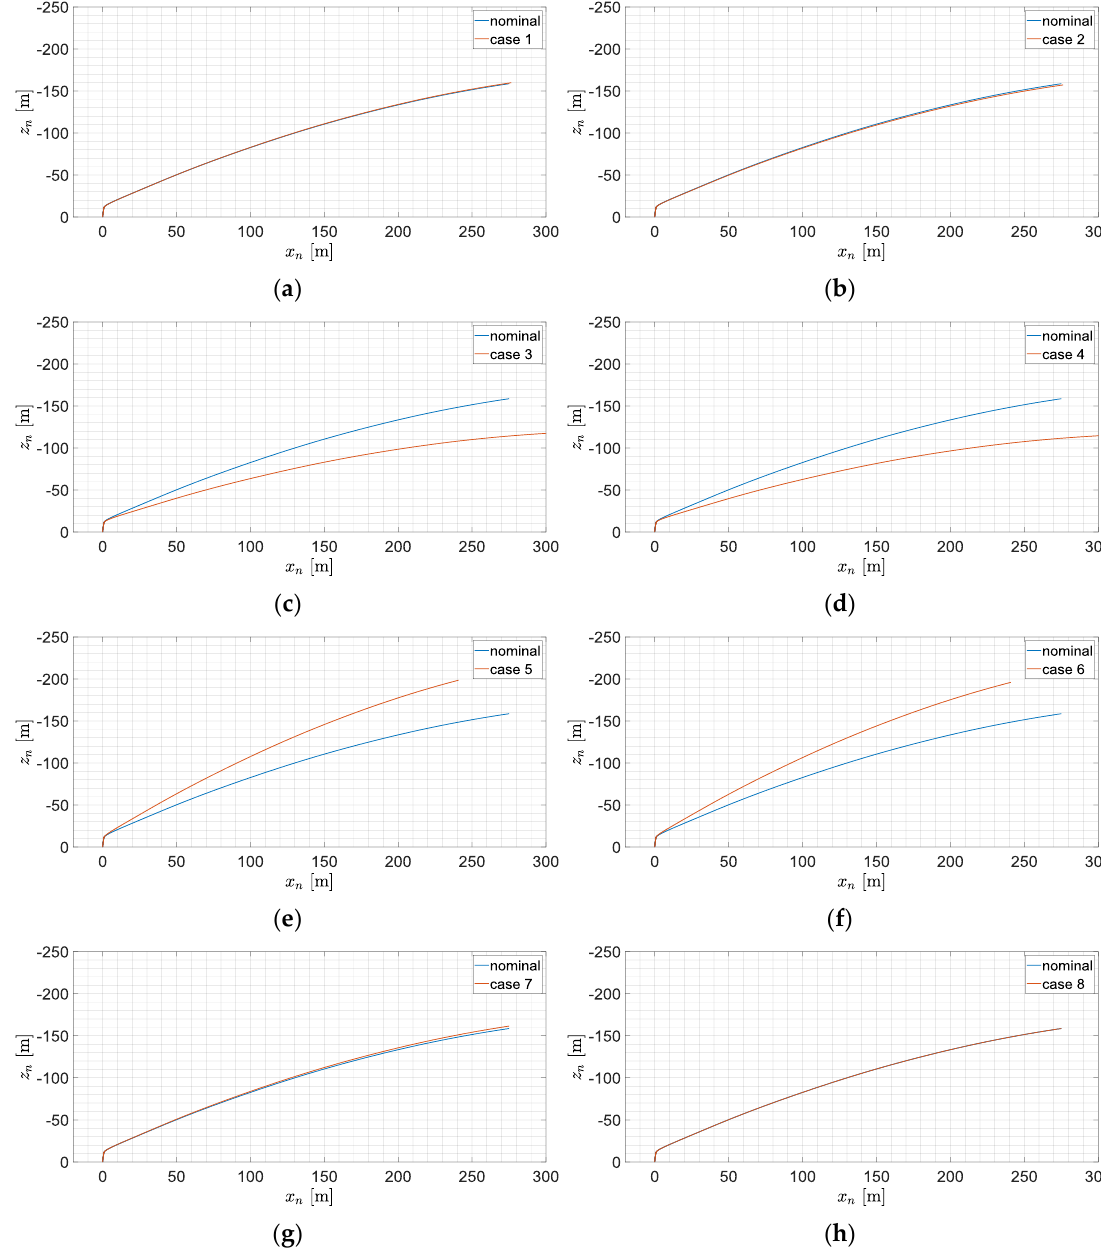
Figure 14. Projectile trajectories’ projections on 𝑂 𝑛 𝑥 𝑛 𝑧 𝑛 for various 𝜏 1 , 𝜏 2 , 𝜏 3 delay combinations: ( a ) 𝜏 1 = 0.189, 𝜏 2 = 0.319, 𝜏 3 = 0.939; ( b ) 𝜏 1 = 0.189, 𝜏 2 = 0.319, 𝜏 3 = 0.961; ( a ) τ 1 = 0.189, τ 2 = 0.319, τ 3 = 0.939; ( b ) τ 1 = 0.189, τ 2 = 0.319, τ 3 = 0.961; ( c ) τ 1 = 0.189, τ 2 = 0.341, τ = 0.939; ( d ) τ = 0.189, τ = 0.341, τ = 0.961; ( e ) τ = 0.211, τ = 0.319, τ = 0.939; ( f ) τ = 0.211, ( c ) 𝜏 1 = 0.189, 𝜏 2 = 0.341, 𝜏 3 = 0.939; ( d ) 𝜏 1 = 0.189, 𝜏 2 = 0.341, 𝜏 3 = 0.961; ( e ) 𝜏 1 = 0.211, 3 2 3 2 3 1 1 1 τ = 0.319, τ = 0.961; ( g ) τ = 0.211, τ = 0.341, τ = 0.939; ( h ) τ = 0.211, τ = 0.341, τ = 𝜏 𝜏 𝜏 𝜏 𝜏 𝜏 𝜏 𝜏 2 3 2 3 2 3 1 1 2 = 0.319, 3 = 0.939; ( f ) 1 = 0.211, 2 = 0.319, 3 = 0.961; ( g ) 1 = 0.211, 2 = 0.341, 3 = 0.939; ( h ) 𝜏 1 = 0.211, 𝜏 2 = 0.341, 𝜏 3 = 0.961.